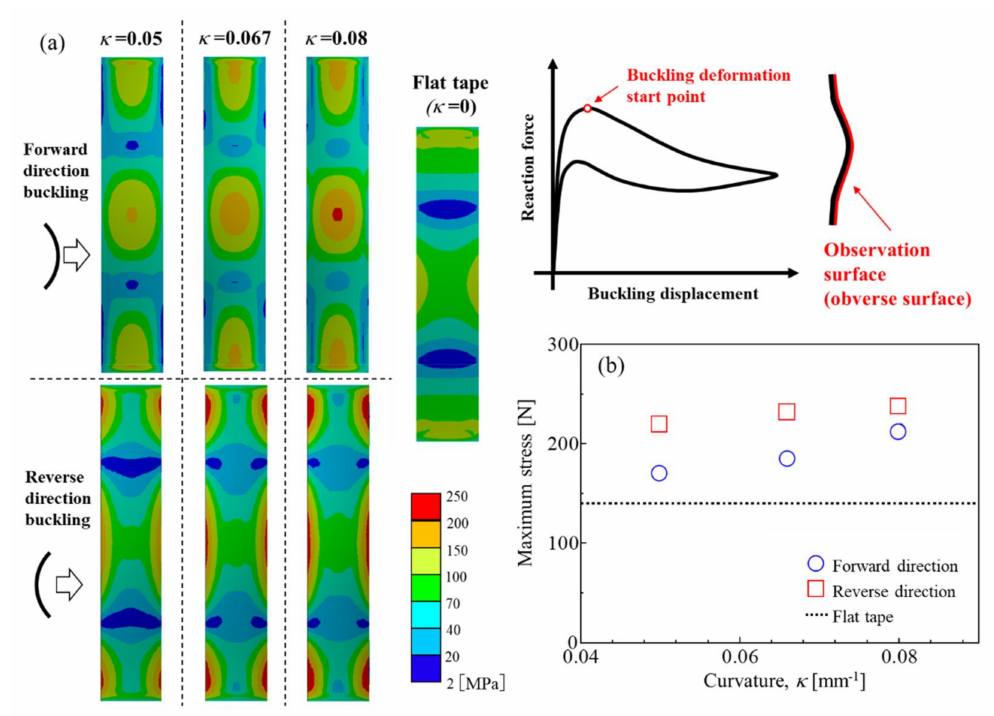
Figure 12. The numerically obtained ( a ) stress distribution and ( b ) κ dependence of maximum stress on the obverse surface of each specimen for each buckling direction at the buckling deformation start